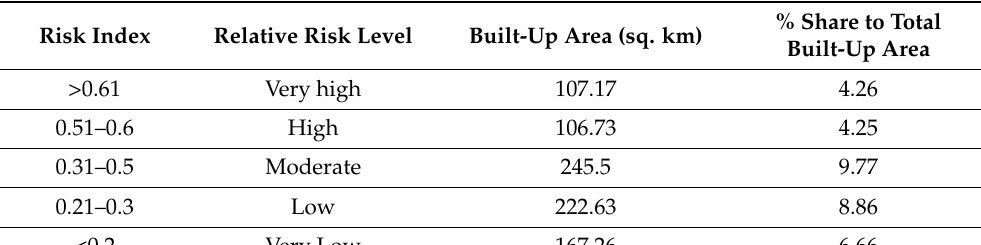
Table 3. Built-up risk index with relative risk levels and their share to the total built-up area in coastal plains of Tamil Nadu.